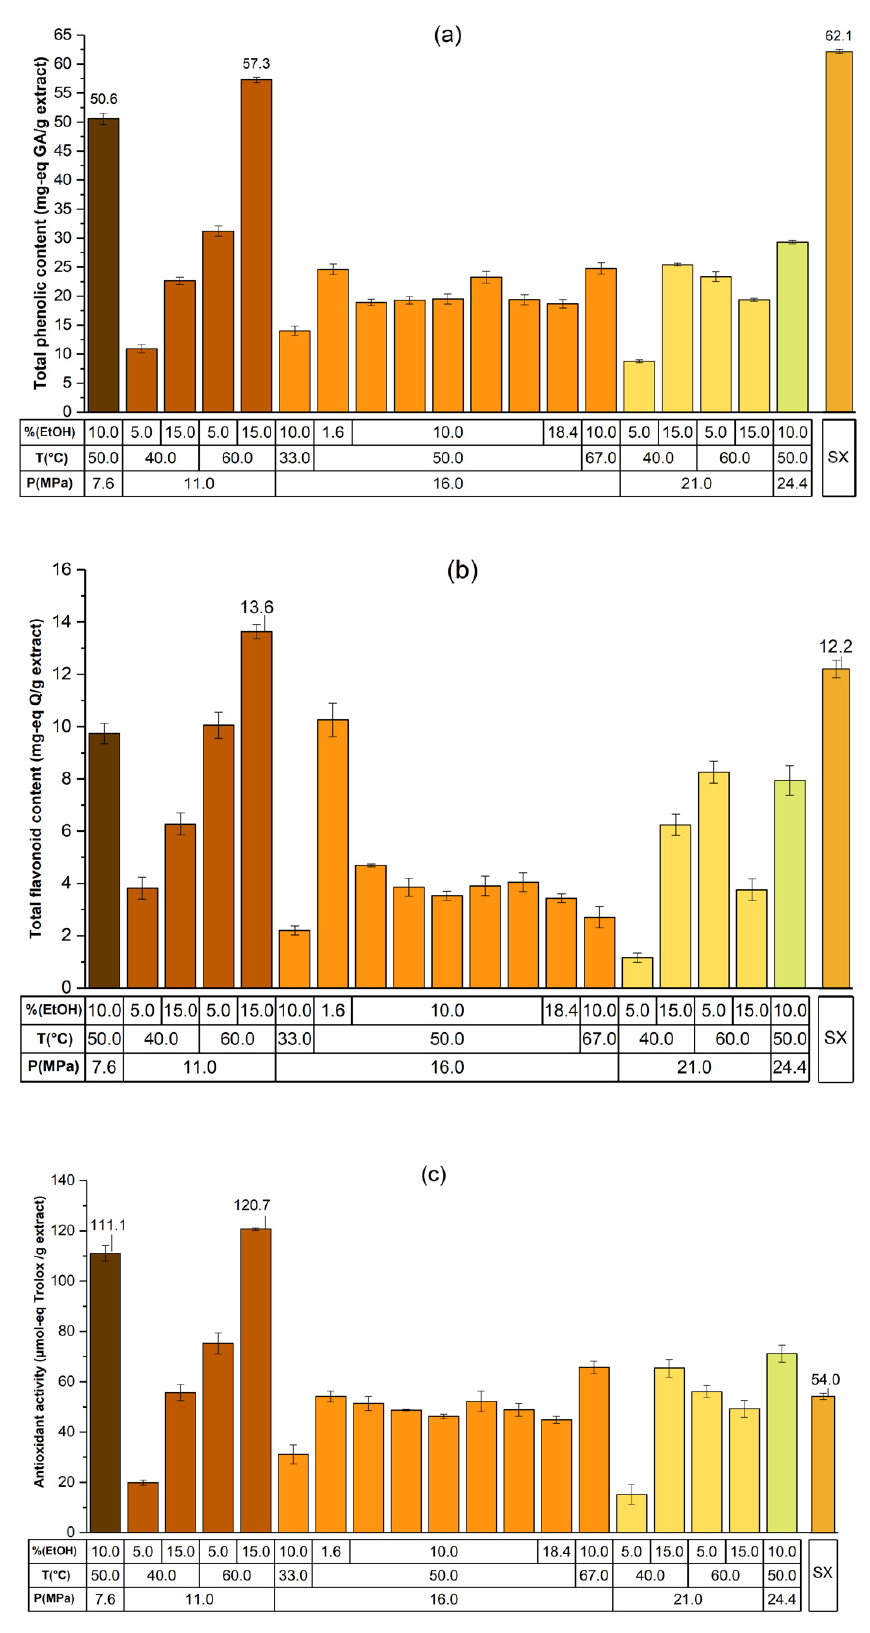
Figure 4. Total phenolics content ( a ), total flavonoids content ( b ), and antioxidant activity ( c ) as measured by the radical scavenging method from supercritical fluid and Soxhlet extracts.